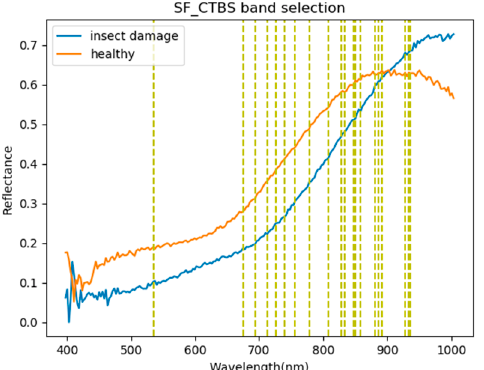
Figure 13. Visualization of the SF_CTBS band selection results. The first five bands are 936, 858, 534, 927, and 693 nm.